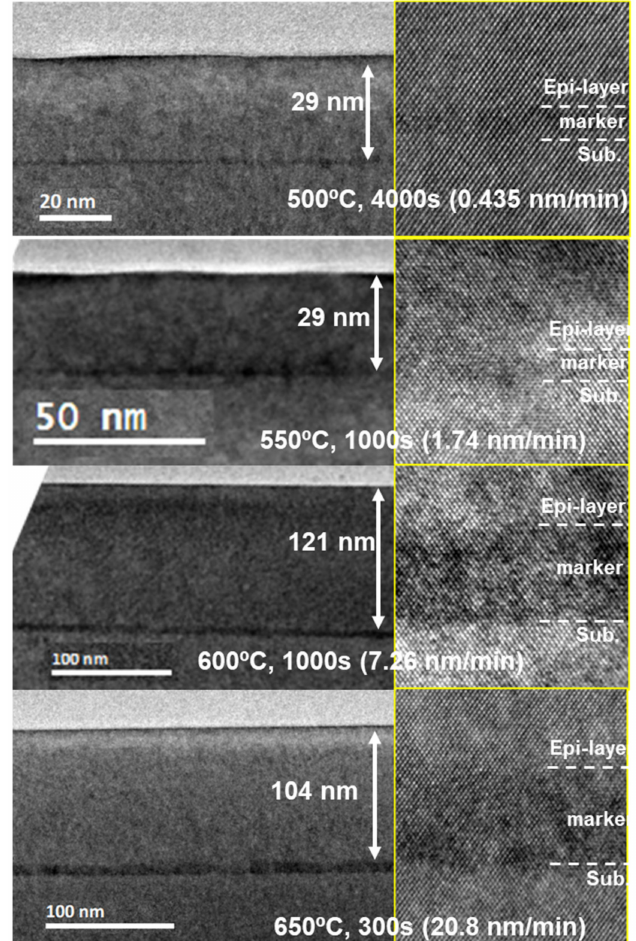
Figure 2. Cross-sectional TEM images of the Si layers grown using trisilane at 500–650 ◦ C with a SiGe marker layer. High-resolution TEM images of the interface are also shown.